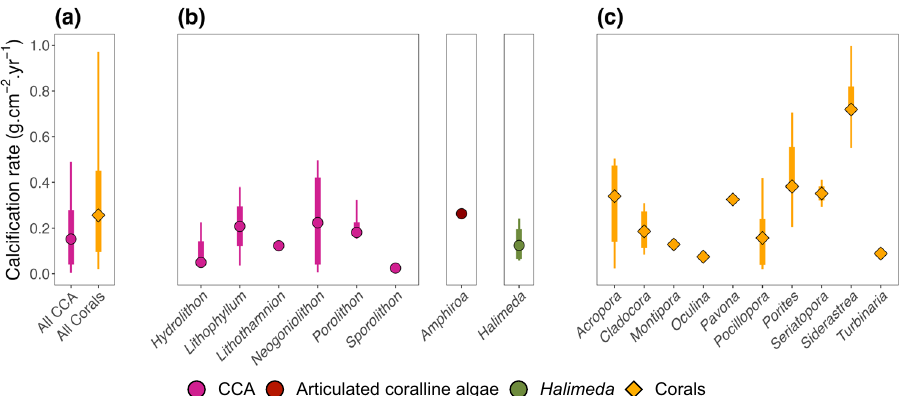
Fig. 3 Crustose coralline algae (CCA), articulate coralline algae, Halimeda spp., and coral calci fi cation rates from laboratory measurements. Genus- speci fi c, area-normalised calci fi cation rates for a range of common CCA and coral species compiled from 55 and 66 studies, respectively. Note these are normalised to organism surface area, rather than reef horizontal area. Points show the median, thick error bars show the interquartile range, and thin error bars show the 99% quantile. Aggregate CCA and coral statistics in ( a ) are calculated from all underlying data for corals, and for CCA only for CCA. Smaller panels in ( b ) denote articulate taxa and Halimeda spp., with both b and c highlight the important variability across different coral and CCA